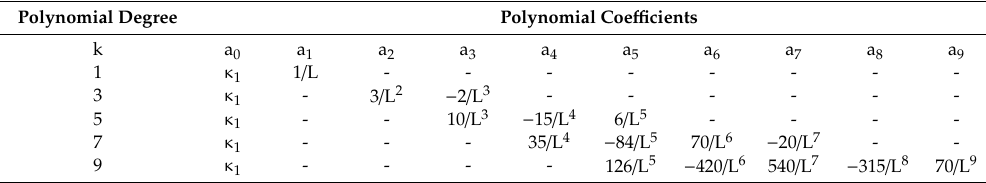
Table 1. The list of dependences for the polynomial coe ffi cients describing the curvature κ (l).